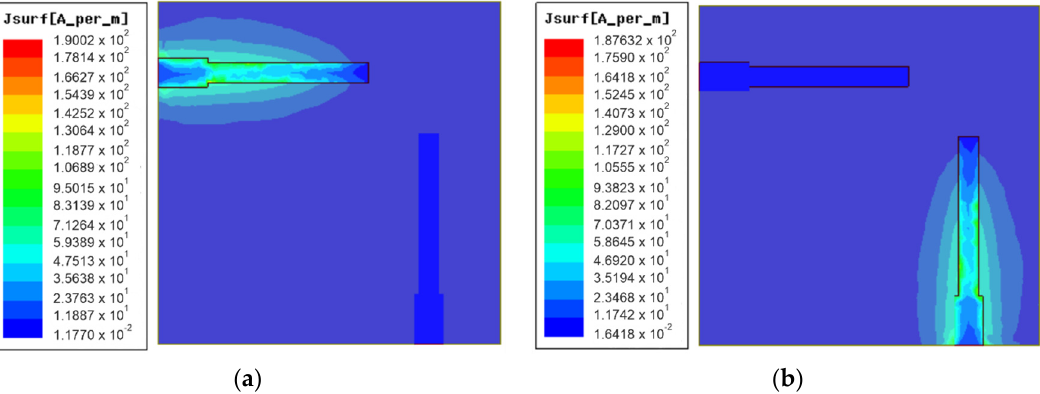
Figure 3. Simulated surface current densities at 3.5 GHz for ( a ) port 1 and ( b ) port 2 excitations.